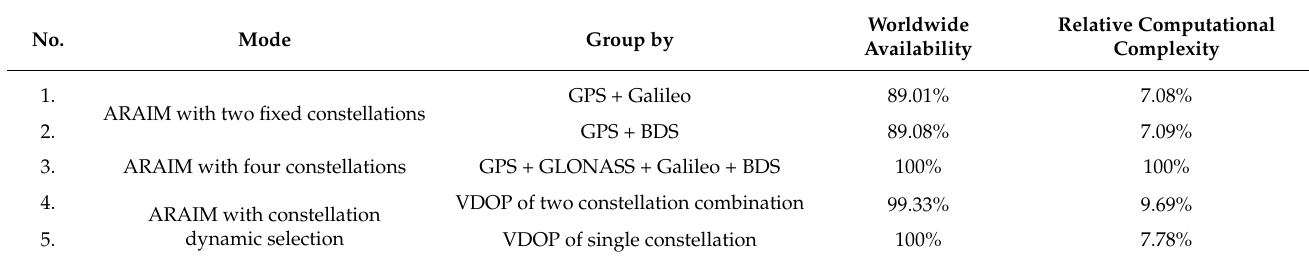
Table 3. Worldwide availability and relative computational complexity of five